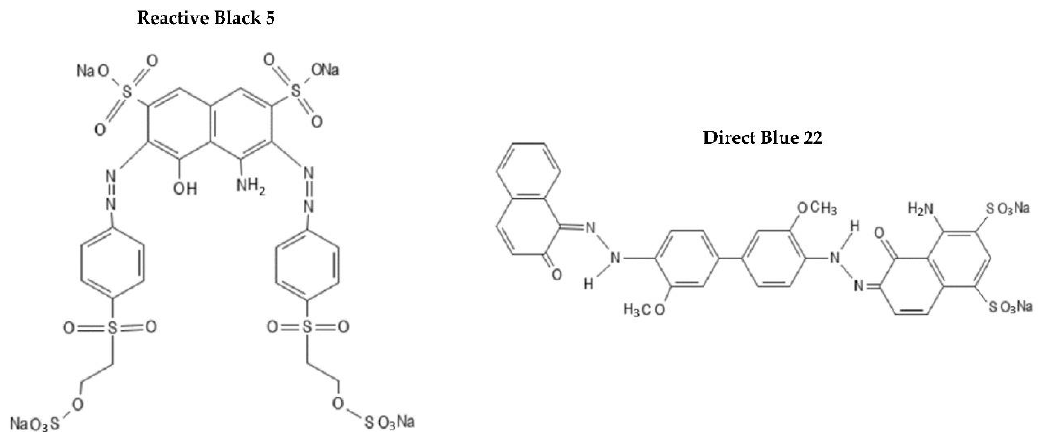
Figure 2. Chemical structure of Reactive Black 5 and Direct Blue 22.